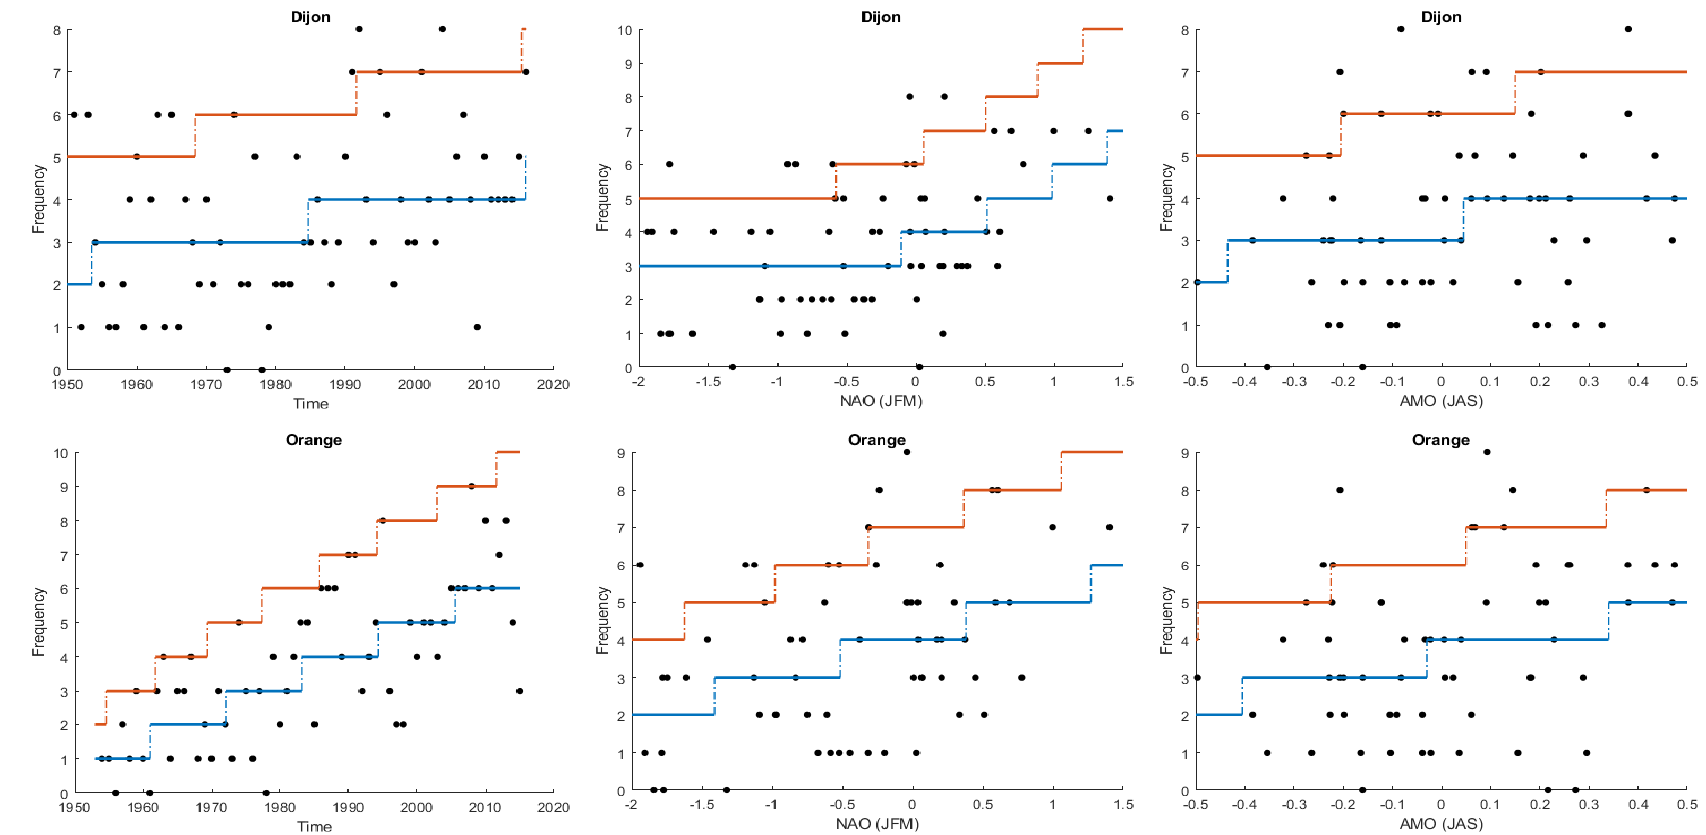
Figure 6. Frequency quantiles corresponding to the non-exceedance probabilities p = 0.5 (blue line) and 0.9 (red line) as a function of each covariate.